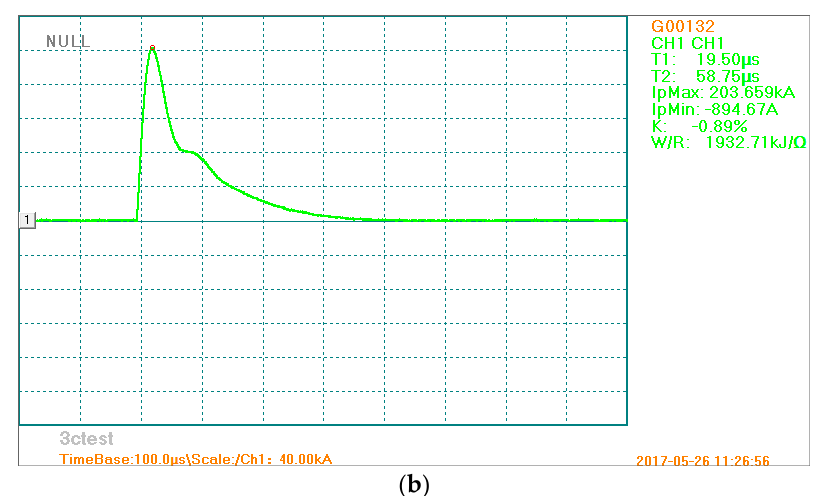
Figure 8. Lightning impact currents applied in the tests. ( a ) 100 kA, ( b ) 200 kA.